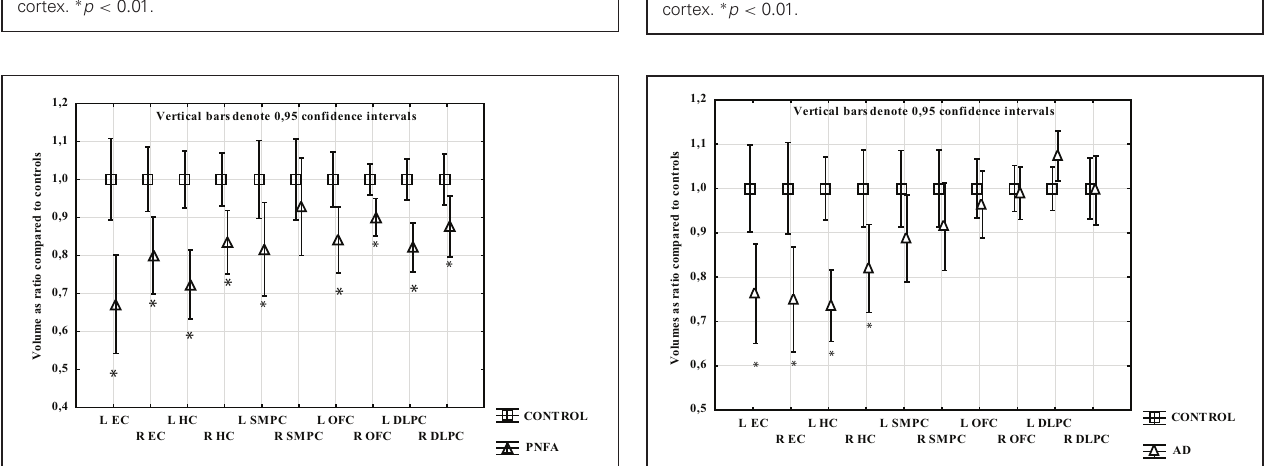
FIGURE 5 | The volume of measured region in AD expressed as a ratio of CTL volume. CTL volume is set to 1. X-axis denotes the included regions: EC, entorhinal cortex; HC, hippocampus; OFC, orbitofrontal cortex; SMPC, subcallosal medial prefrontal cortex; DLPFC, dorsolateral prefrontal cortex. ∗ p < 0 .